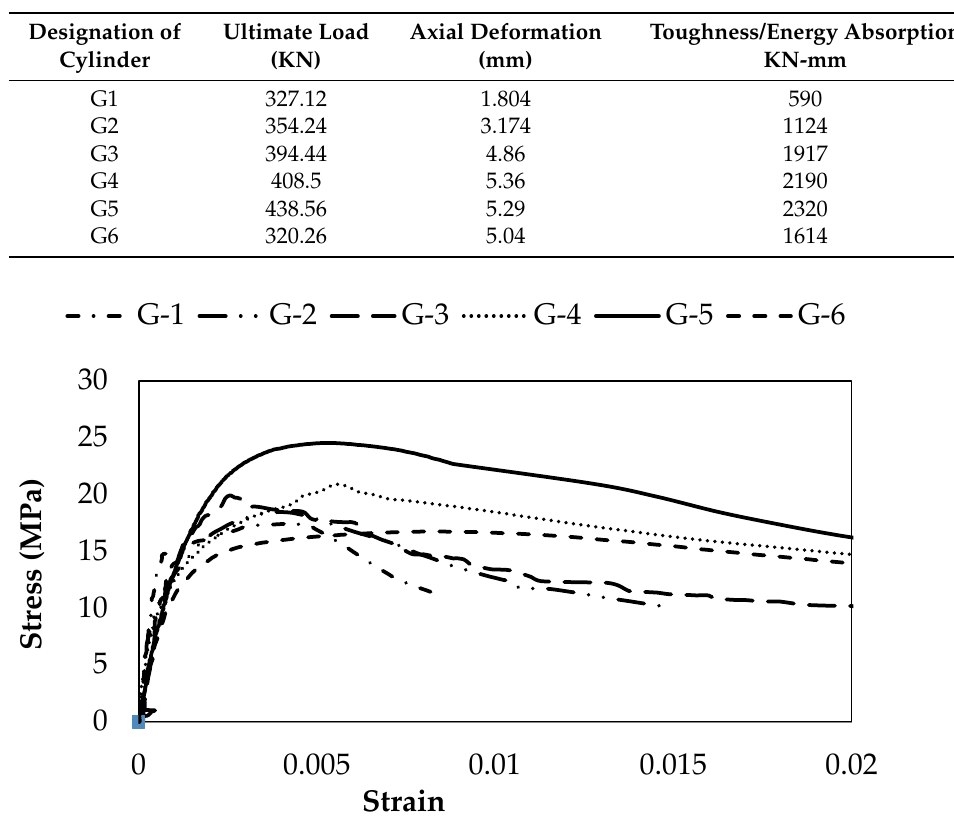
Figure 9. Stress–strain curves for unconfined concrete with steel fibers.